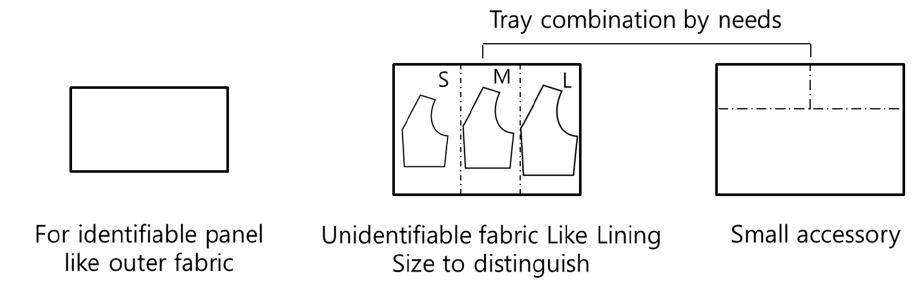
Figure 25. Tray combination by needs.